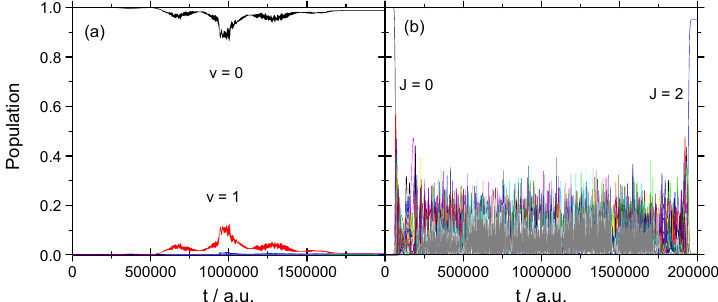
Figure 3. ( a ) The optimal field ε ( t ) obtained with the initial guess, Equation (18), for the rotational excitation, ( v = 0, J = 0) → ( v = 0, J = 2), in the strong-field regime; ( b ) the spectrum of ε ( t ).